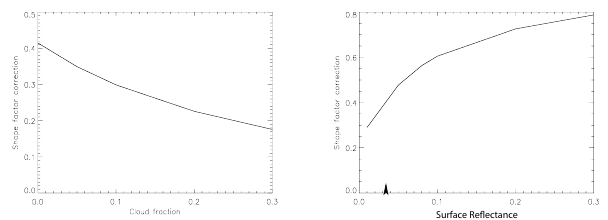
Figure 6. Shape factor correction sensitivity to cloud fraction (left) and surface reflectance (right). The arrow indicates the surface re- flectance value corresponding to the reference